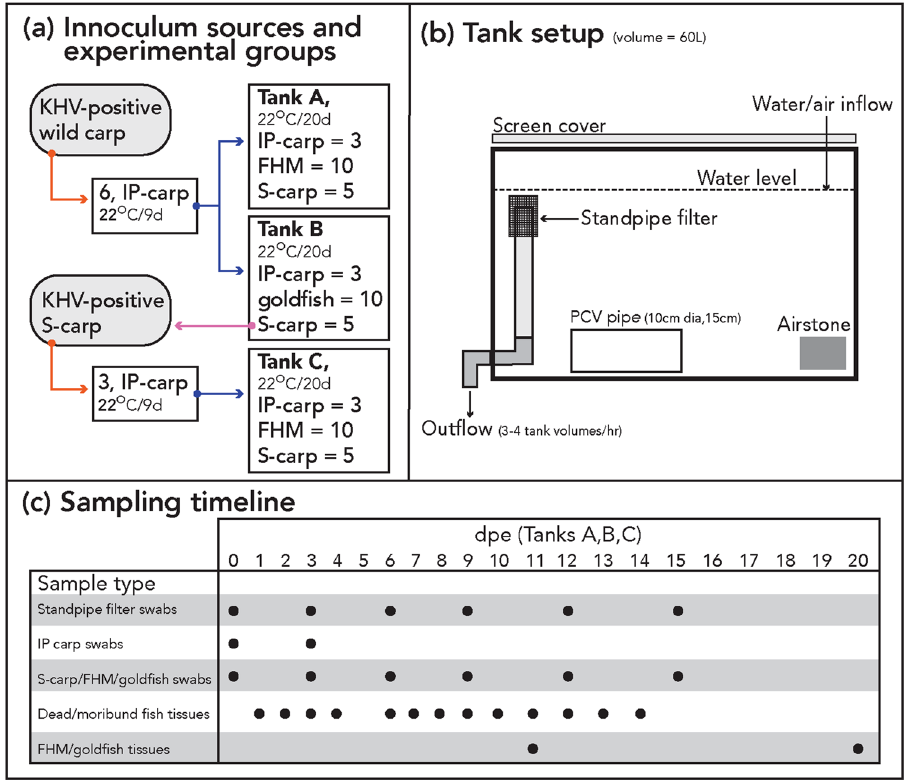
Figure 2. ( a ) Shows a schematic of the cohabitation disease trial. Vermillion arrows denote inoculation of IP-carp with CyHV-3 positive tissue homogenate, blue arrows denote introduction of IP carp for cohabitation with fishes in experimental tanks, and the reddish purple arrow indicates the tissue origin of CyHV-3-positive S-carp. ( b ) Shows a schematic of experimental flow through chambers with black arrows indicating the direction of water flow. ( c ) Shows a time-line of various